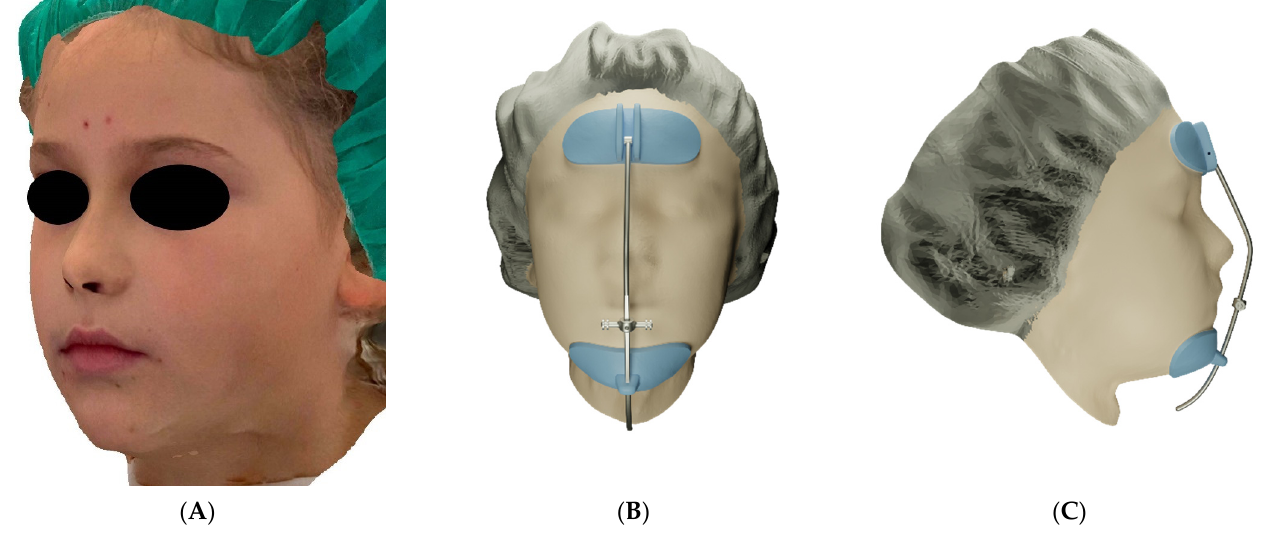
Figure 5. ( A ) The 3D scan of the patient’s face. ( B , C ) The 3D model of the customized facemask.